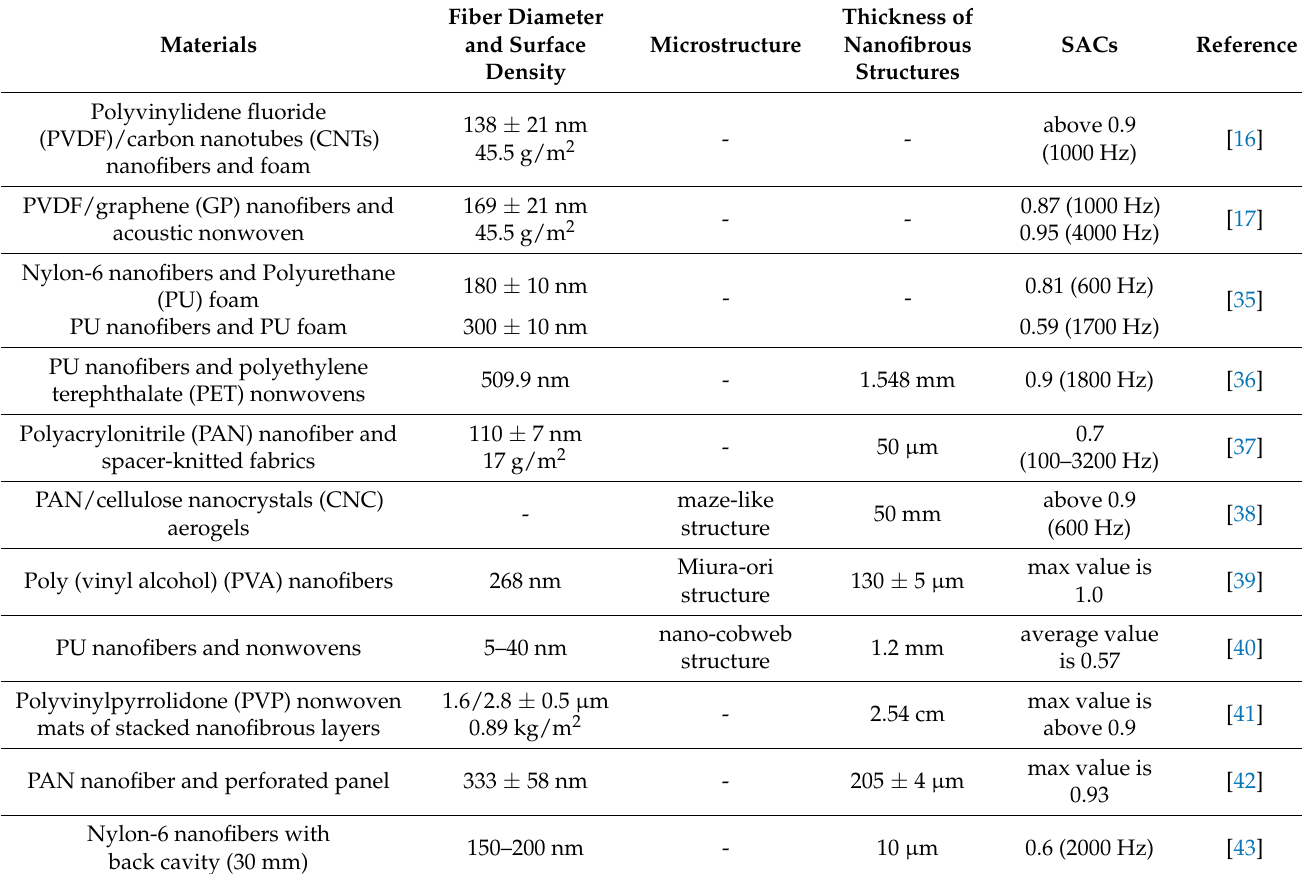
Table 1. Summary of the properties and sound absorption performance of electrospun mi-